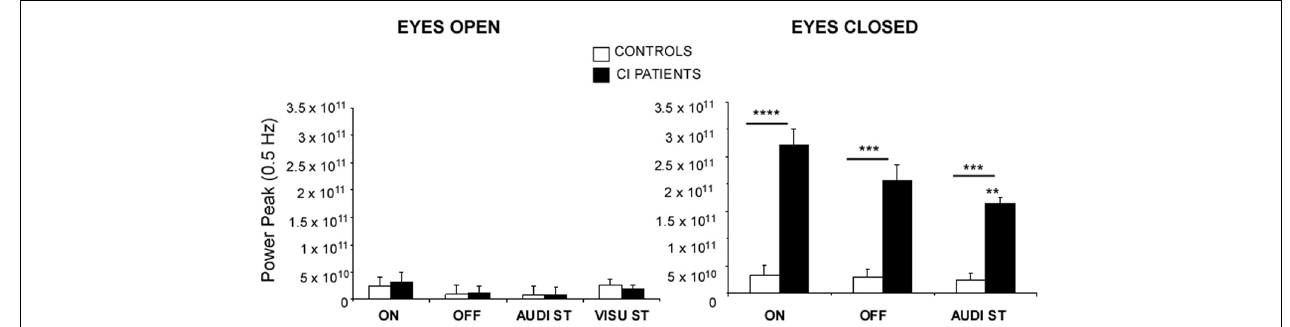
FIGURE 2 | Posture control of the CI patients in dynamic conditions. The spectral power density peaks provide by the wavelet transform at the 0.5Hz stimulus frequency of sinusoidal platform translation in the for-aft direction are expressed on the ordinates for each of the different experimental conditions: with (EO) or without (EC) vision, with (ON) or without (OFF) hearing,